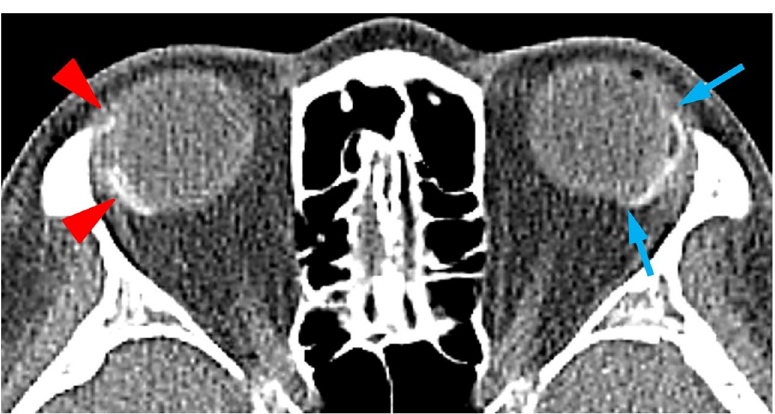
Fig 3. A facial computed tomography image of a patient who underwent Ahmed glaucoma valve (AGV) implantation in both eyes. In our study, one patient underwent two separate implantations in either eye. Initially conventional AGV implantation was performed on the right eye (arrowhead) and free-plate AGV implantation performed on the left eye (arrow) 3 years later. One year after the final surgery, we obtained a facial computed tomography scan to verify implant locations; both plates were safely positioned (well posterior to the equator) without any notable difference in